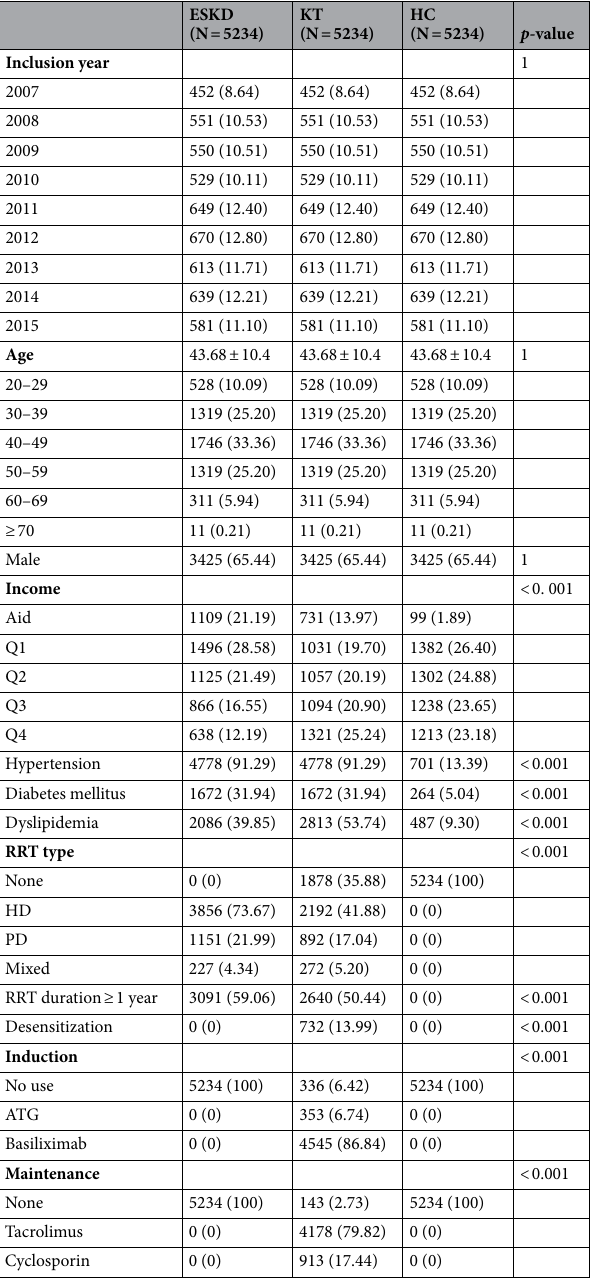
Table 1. Baseline characteristics of study population. Data are presented as the mean ± standard deviation, or n (%). ESKD end-stage kidney disease, KT kidney transplantation, HC healthy control, RRT renal replacement therapy, HD hemodialysis, PD peritoneal dialysis, ATG antithymocyte globulin.